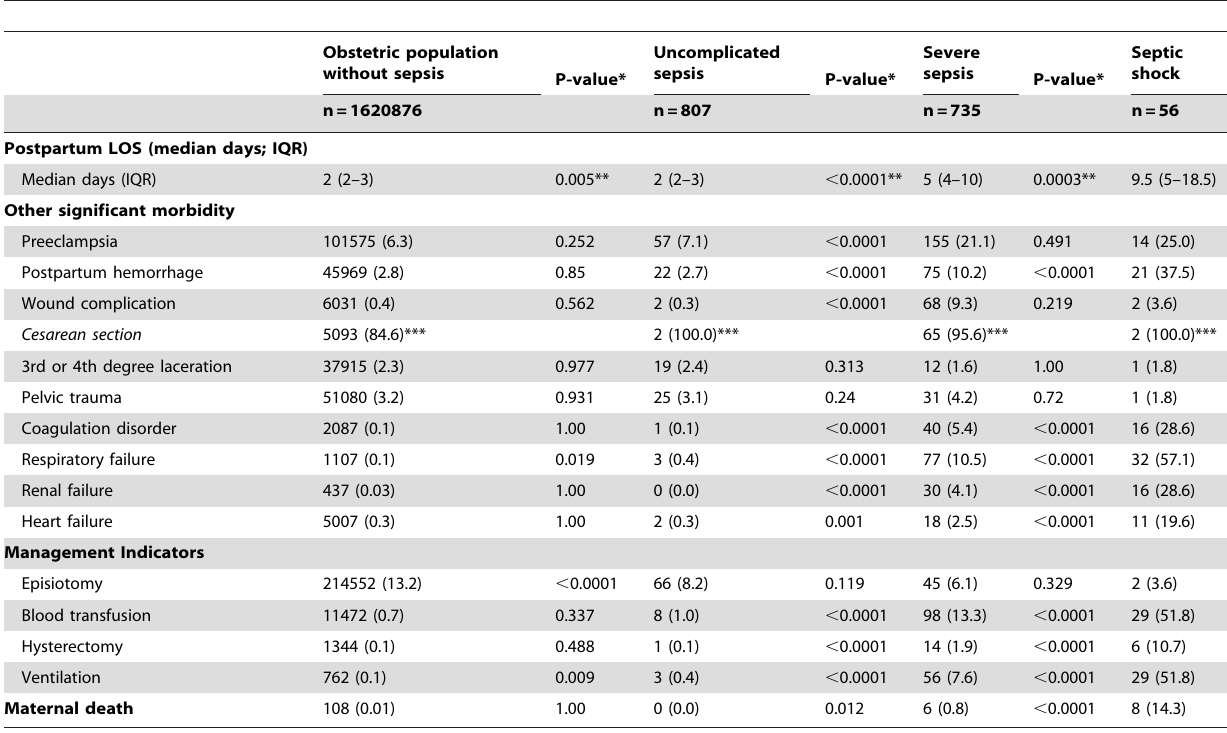
Table 3. Other significant morbidity and maternal death among non-sepsis obstetric population compared to women with uncomplicated sepsis, compared to severe sepsis, compared to septic shock in California (2005–2007).